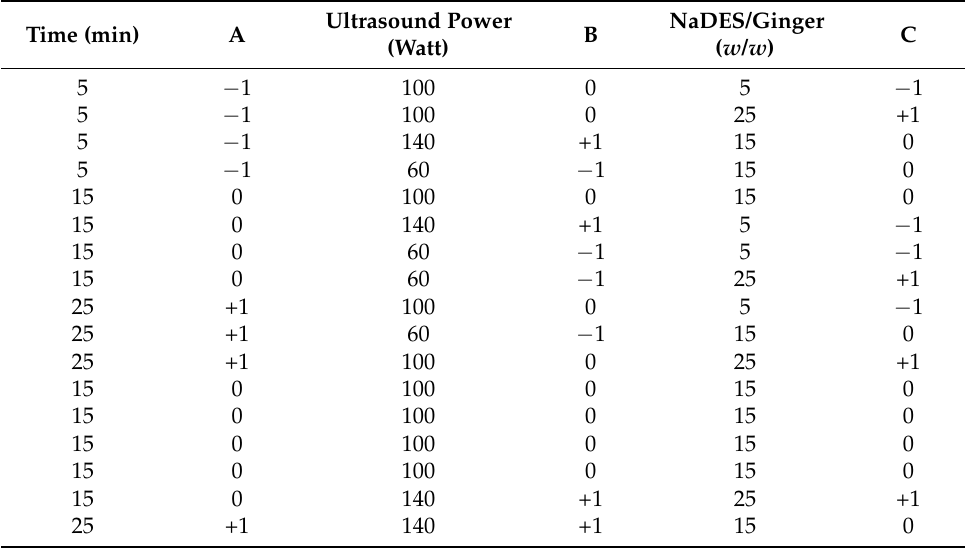
Table 1. Raw and coded values of independent variables of